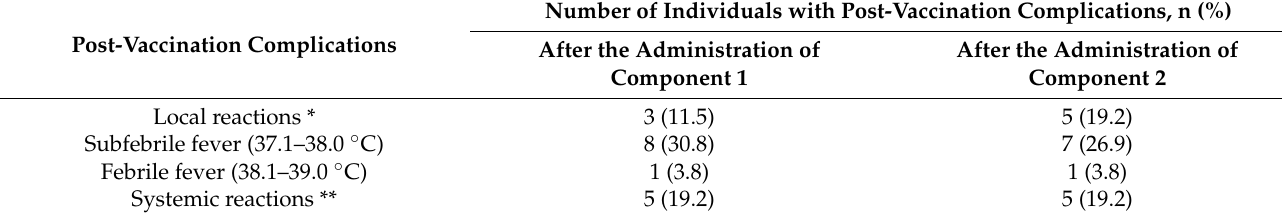
Table 3. Characteristics of post-vaccination complications (n =